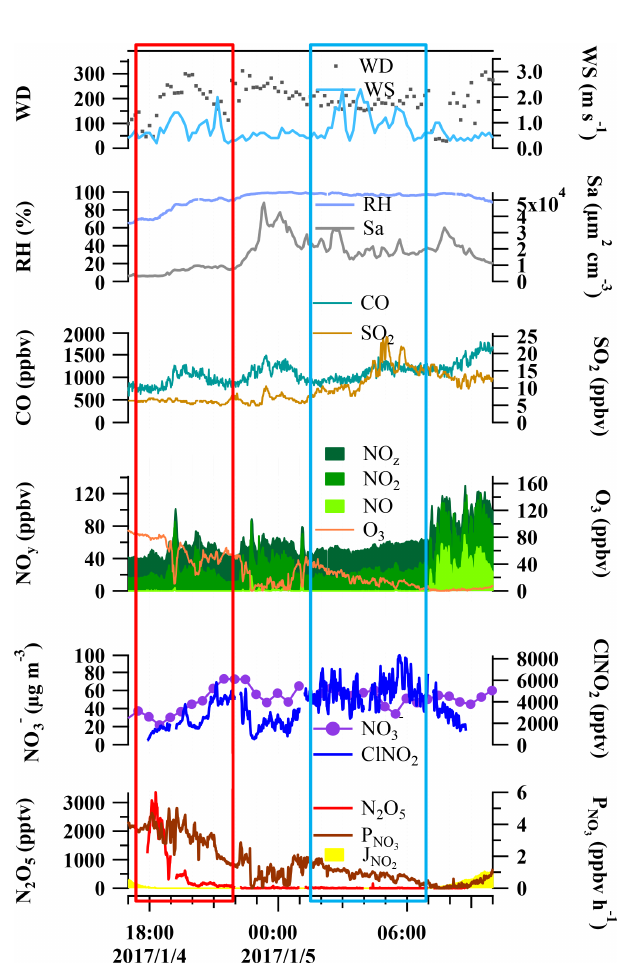
Figure 5. Variation of N 2 O 5 , ClNO 2 , NO − meteorological conditions during the night from 4 to 5 January 2017 as an example from the five selected